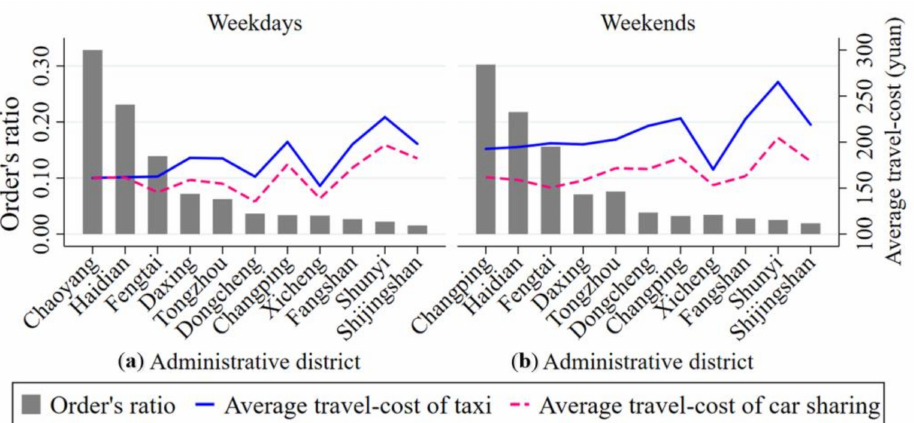
Figure 15. Comparison of travel-cost between taxis and car sharing for each administrative district on weekdays ( a ) and on weekends ( b